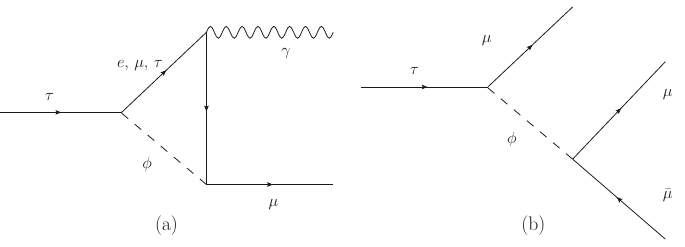
(cid:22)(cid:13) and (b) (cid:28) (cid:22) (cid:22) (cid:22)(cid:22) decays with ! ! (cid:22)(cid:13) , !